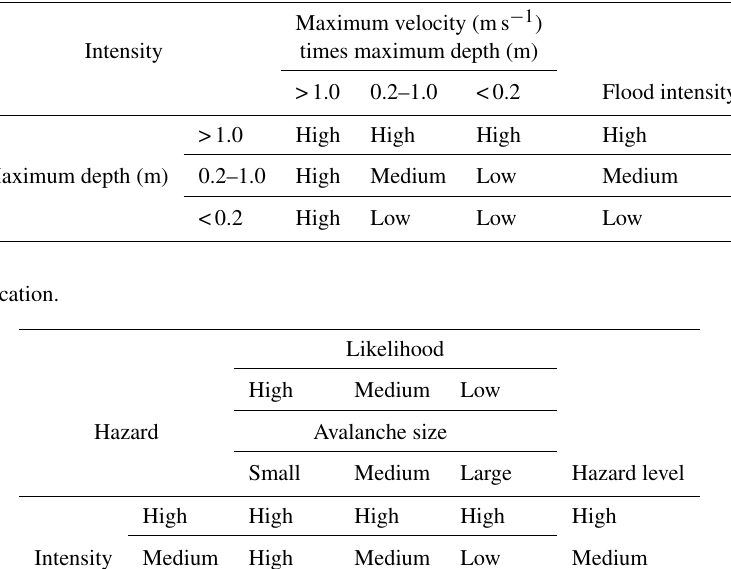
Table 2. Flood intensity classification.